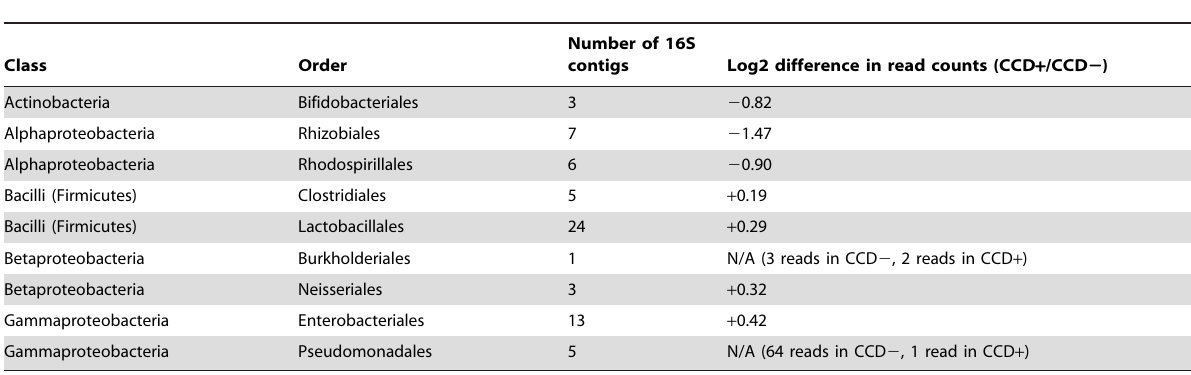
Table 7. Taxonomic distribution of cDNA contigs with homology to 16S ribosomal sequence, by bacterial order.